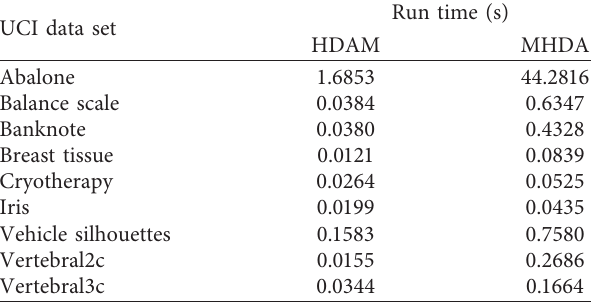
Table 3: Run time of HDAM and